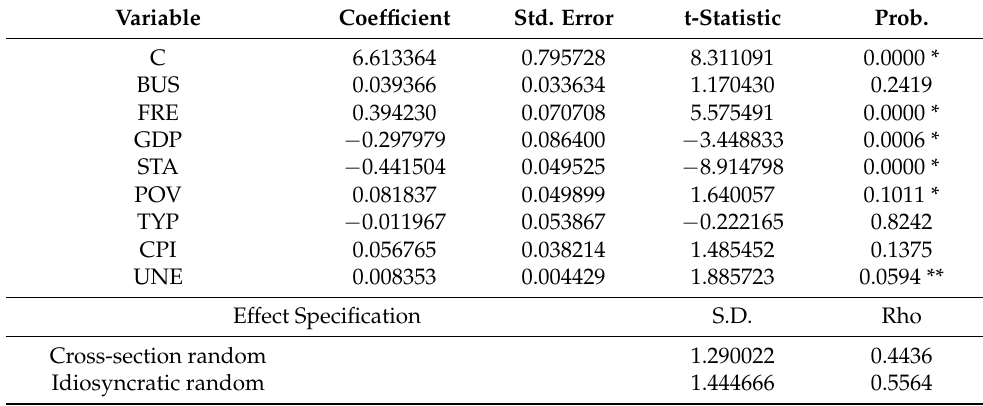
Table 3. Random effect model—panel EGLS (CS